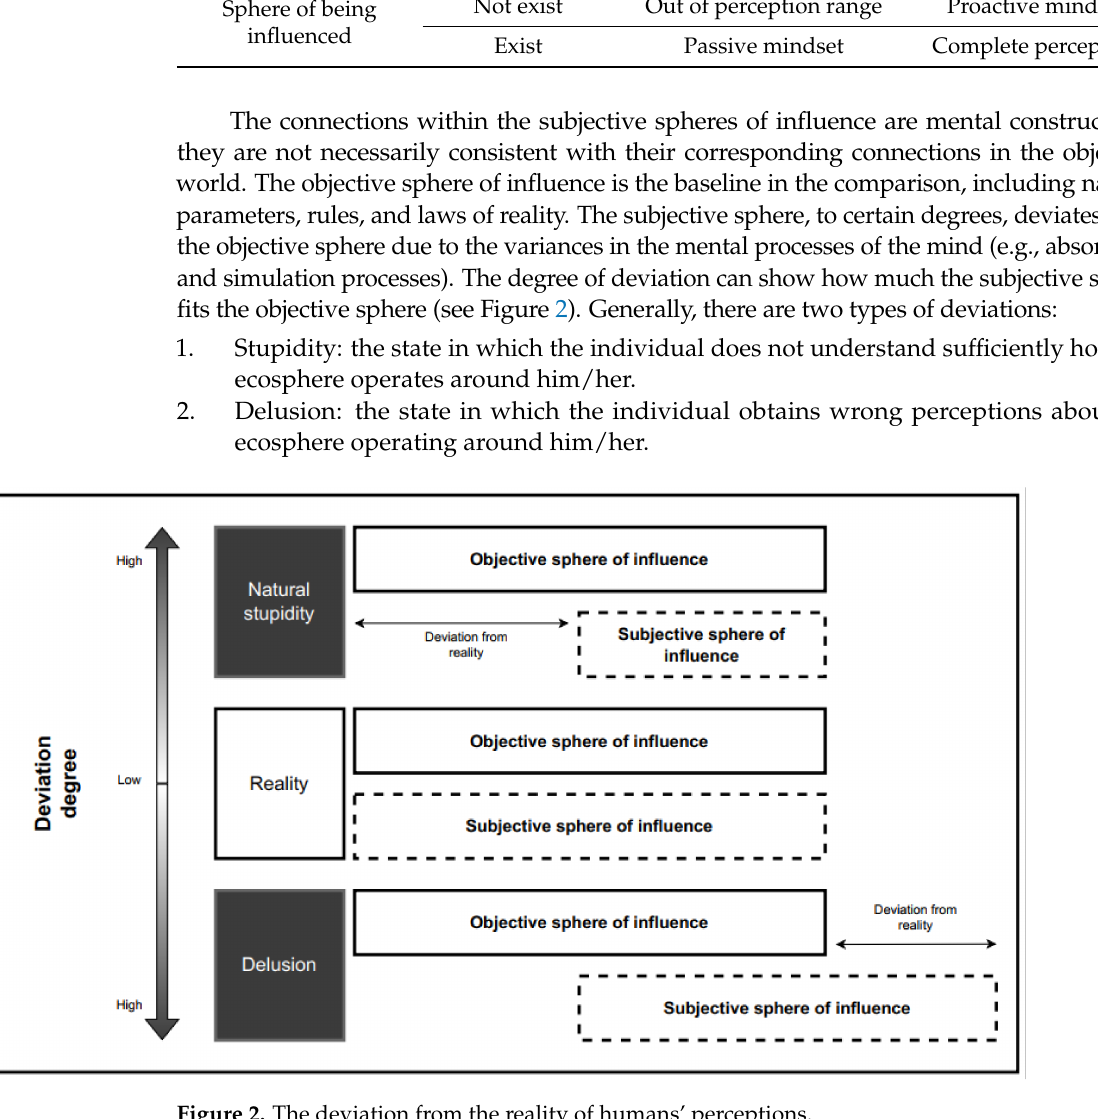
Figure 2. The deviation from the reality of humans’